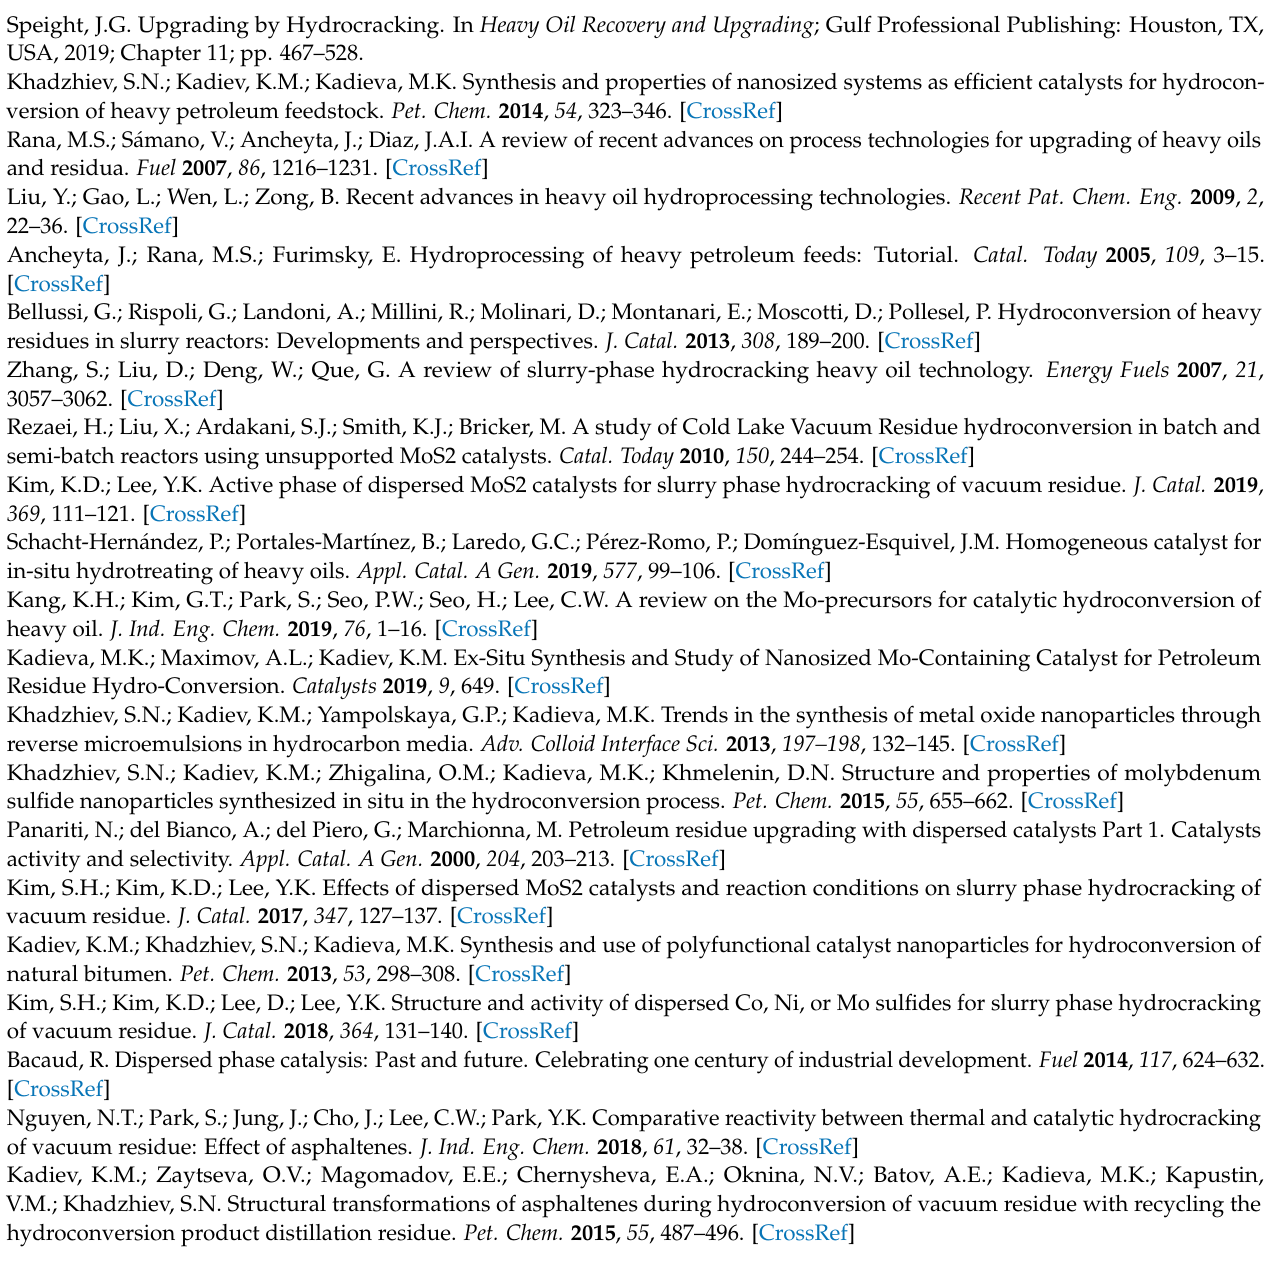
Table S1: Formulas for calculation of MoS 2 cluster parameters, Table S2: Geometrical parameters of catalyst active phase (MoS 2 ) in polycondensation